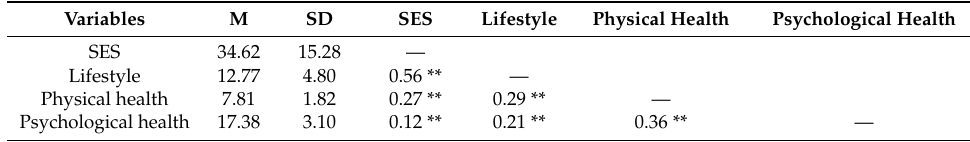
Table 1. Descriptive statistics and correlation coefficients for the study